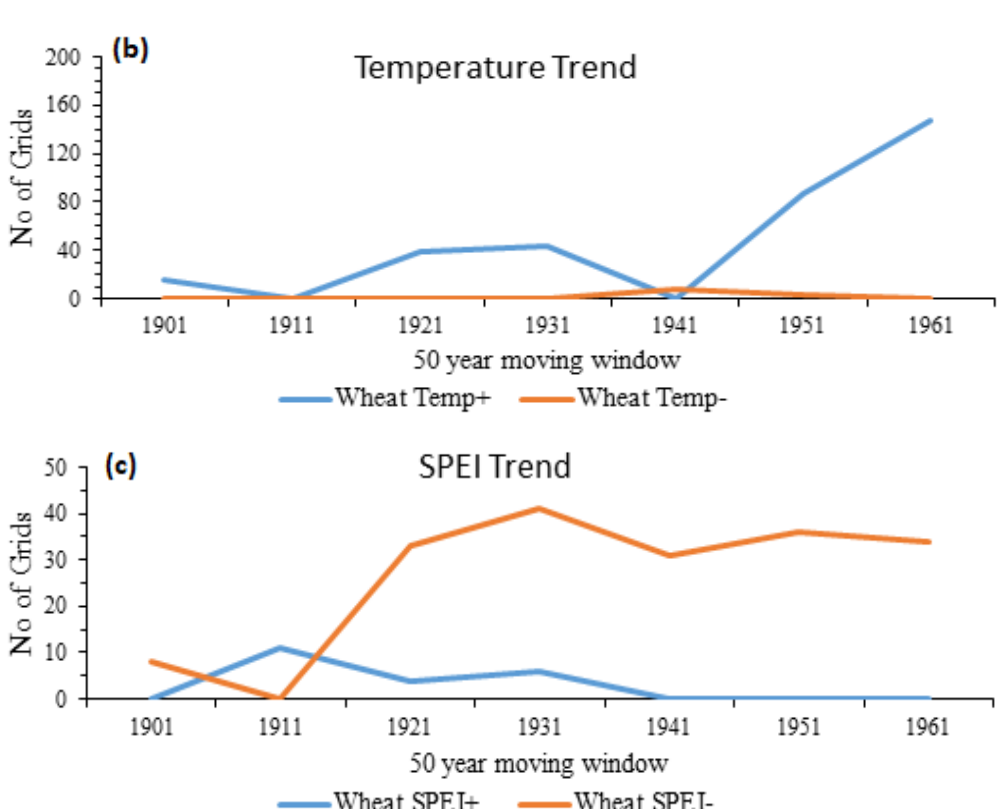
Figure 5 . The number of grid points at which significant changes in ( a ) precipitation, ( b ) mean temperature, and ( c ) SPEI during wheat-growing season for different 50-year periods for 1901–2010.